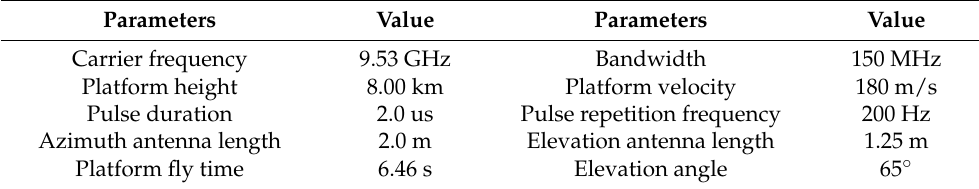
Table 2. Basic SAR system parameters for experiments in Figure 12.